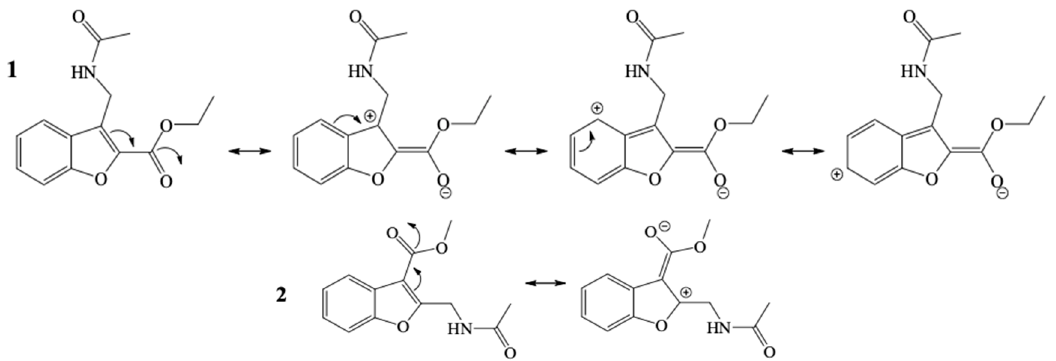
Figure 4. Indices of local electrophilicity ω k (Parr) in compounds 1 and 2